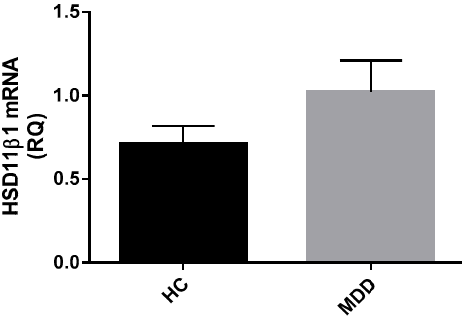
Figure 5. Relative quantification of HSD11 β -1 in MDD patients and healthy controls. Data displayed as means with SEM. There is no difference in gene expression of HSD11 β -1 between MDD